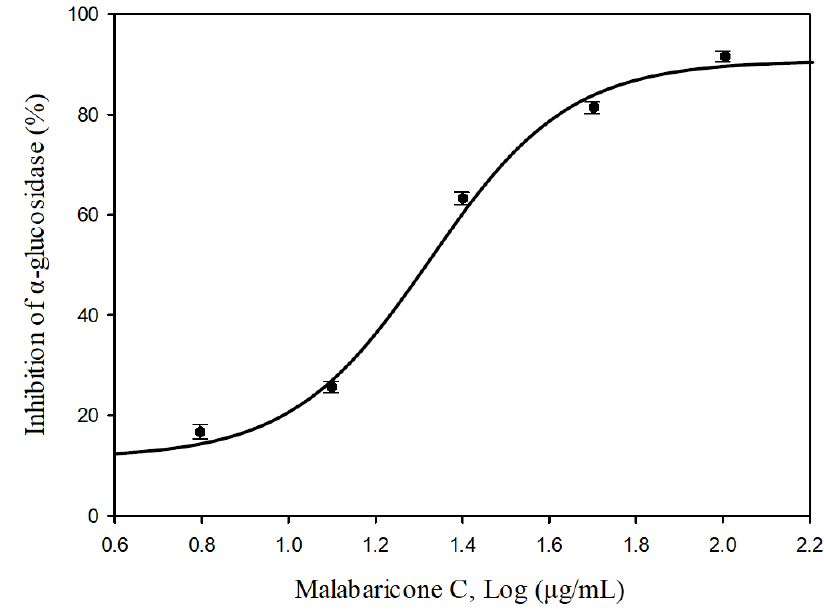
Figure 3. Dose-response (IC 50 ) curve of malabaricone C. Each point represents the average of triplicate measurements.